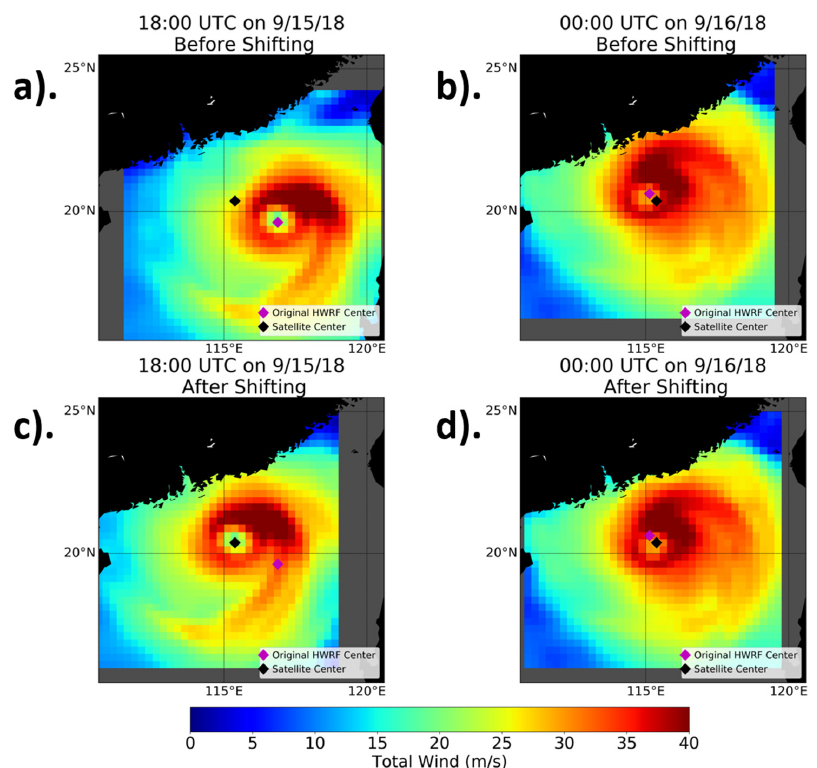
Figure 8. Top panels: The resampled HWRF winds at model times before ( a ) and after ( b ) the SMAP pass over Typhoon Mangkhut on 15 September 2018 at 22:34 UTC before spatial shifting was performed. Bottom panels: The resampled HWRF winds at model times before ( c ) and after ( d ) the SMAP pass after spatial shifting was performed. The SMAP storm center is indicated by the black diamond. The original HWRF storm center is indicated by the magenta diamond.